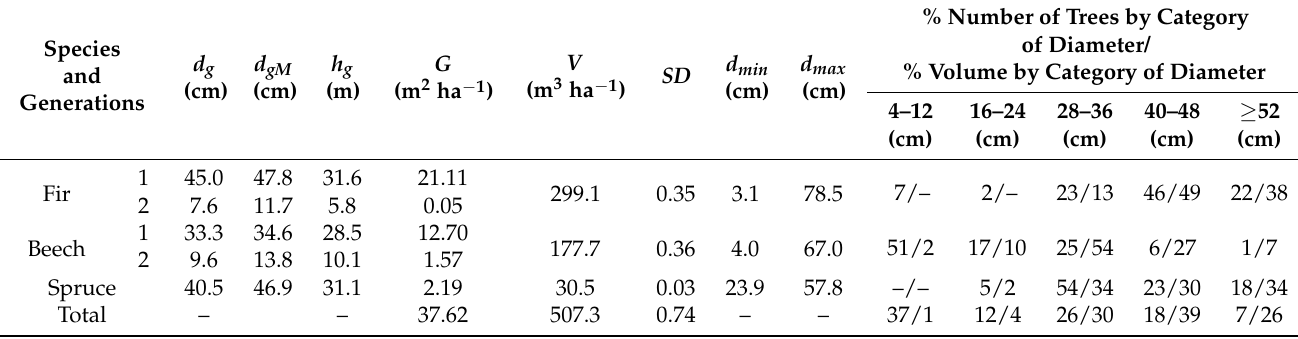
Table 2. Biometric characteristics (100 × 100